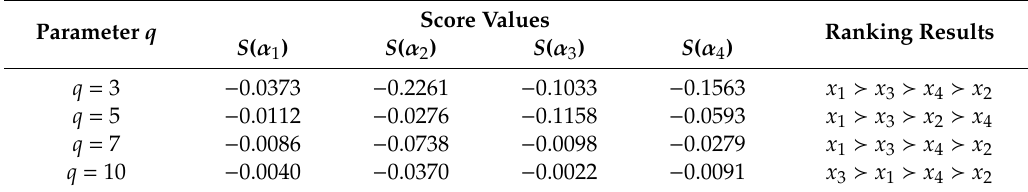
Ranking Results